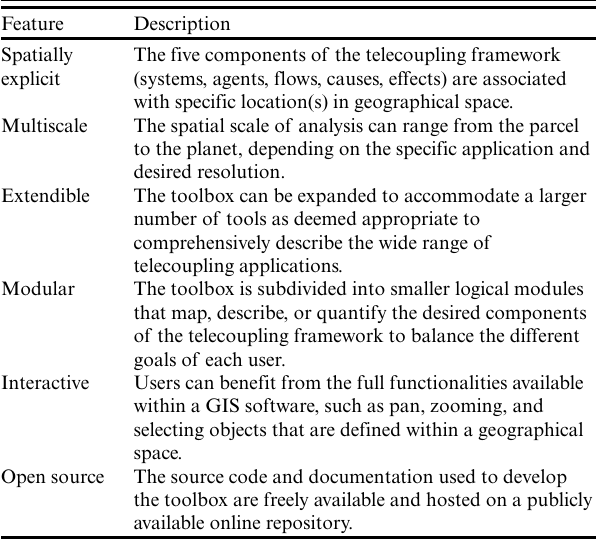
Table 1 . Main features of the Telecoupling Toolbox and their